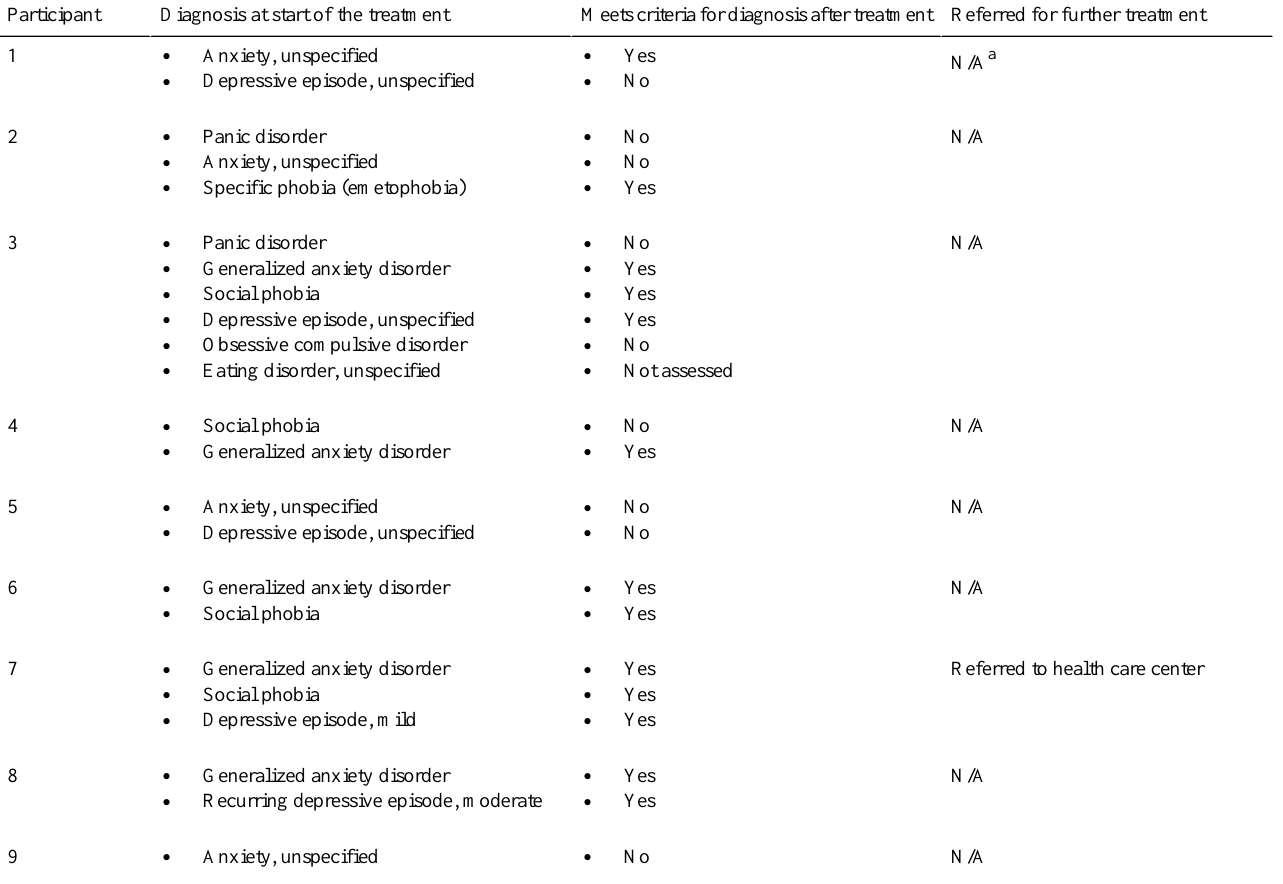
Table 5. Diagnosis at start and end of treatment assessed by the diagnostic interview, PRIME-MD.